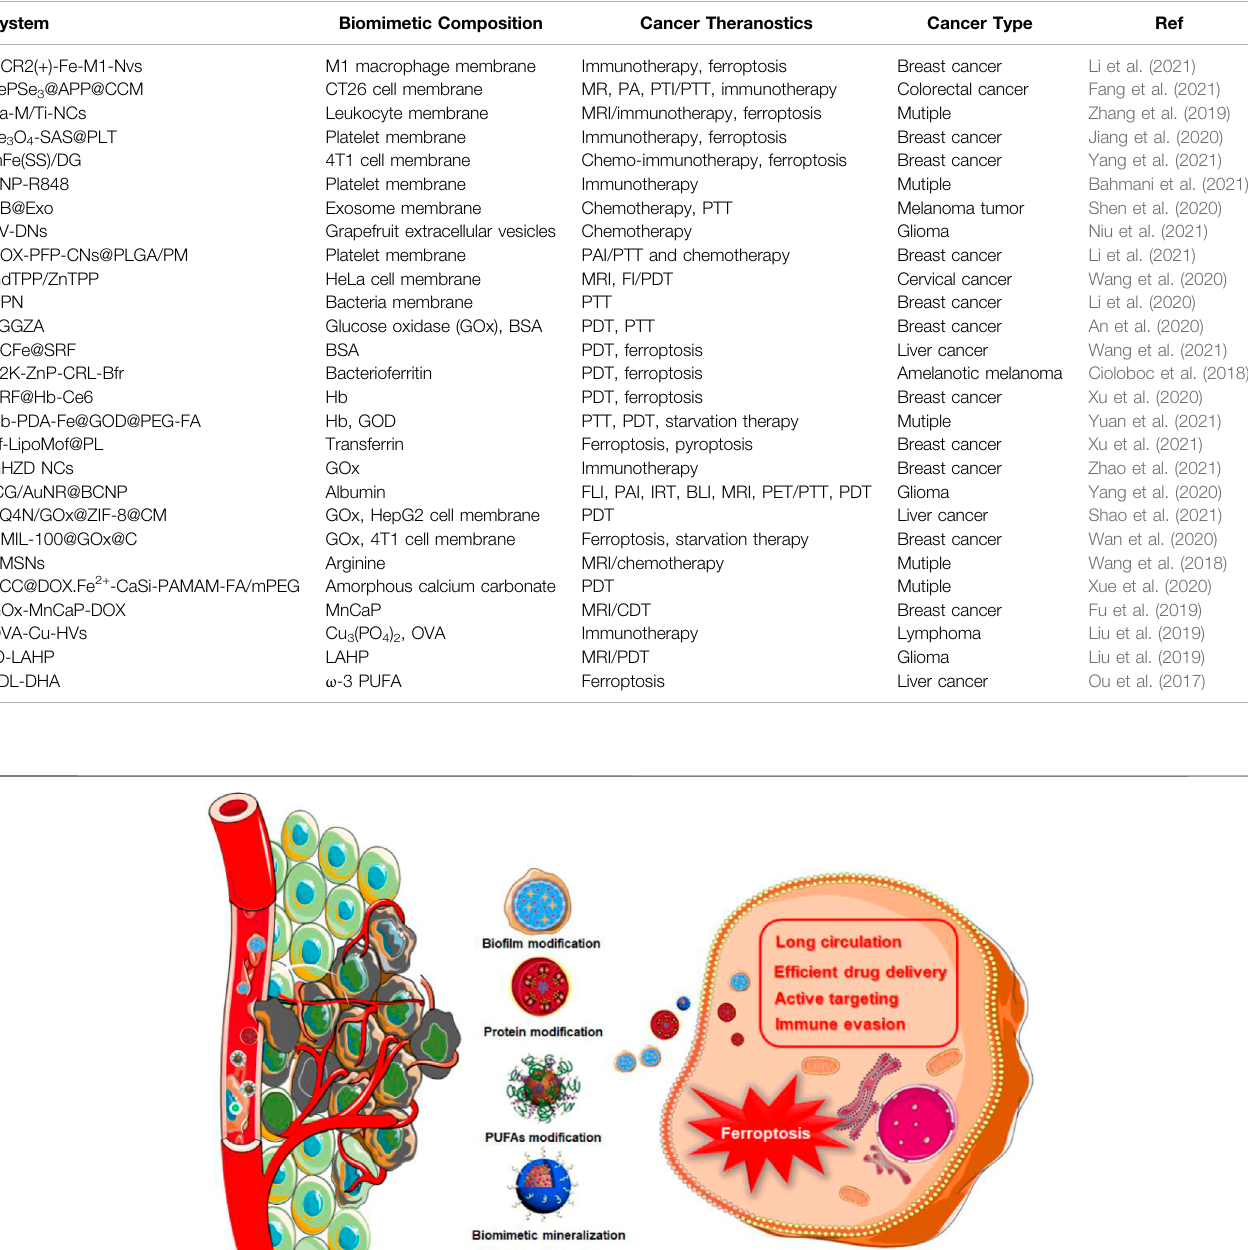
Frontiers in Chemistry |